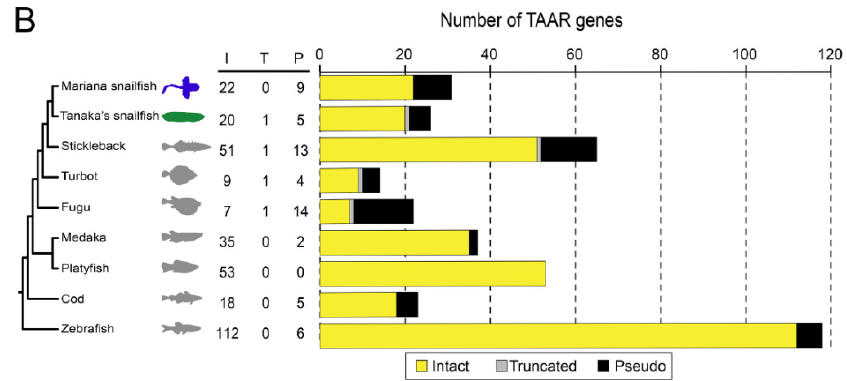
Figure 1. Numbers of olfactory receptor (OR) genes ( A ) and trace amine-associated receptor (TAAR) genes ( B ) in the genome sequences of nine fish species. “I”, “T”, and “P” represent the number of intact genes, truncated genes, and pseudogenes, respectively. The phylogeny of nine fish species was taken from previous